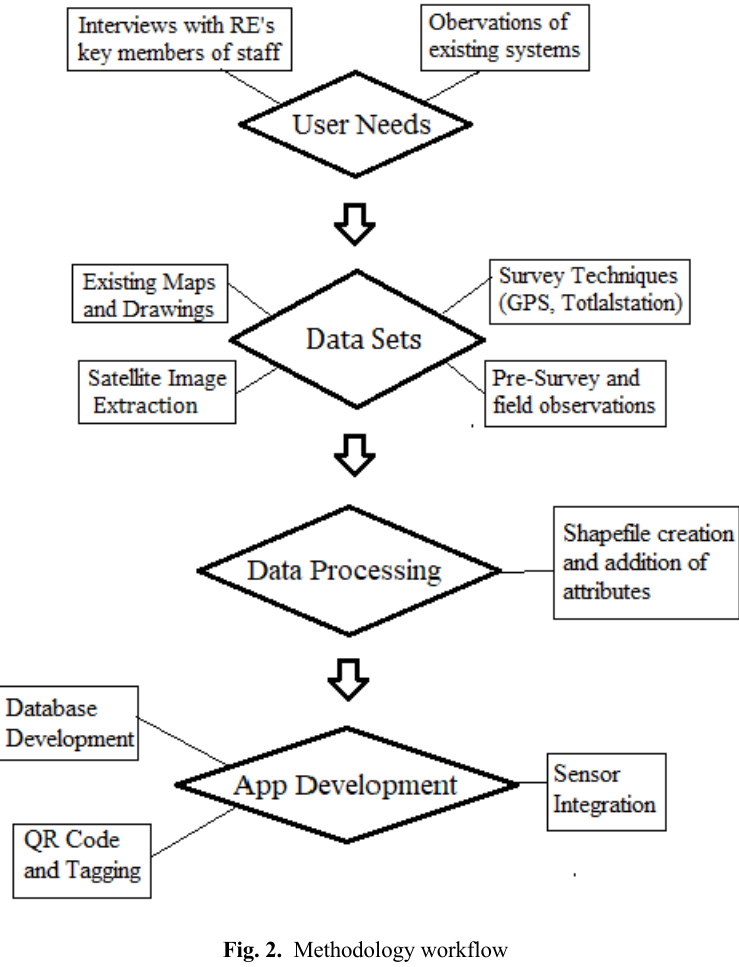
Fig. 2. Methodology